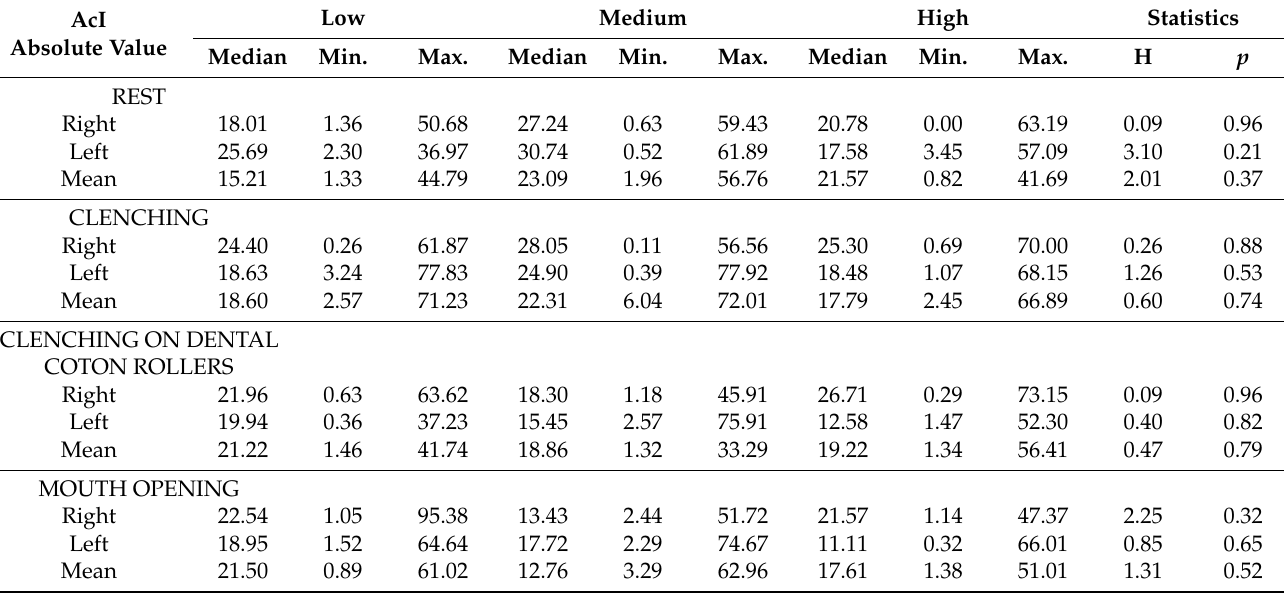
Table 4. The absolute values of activity index (AcI) in studied